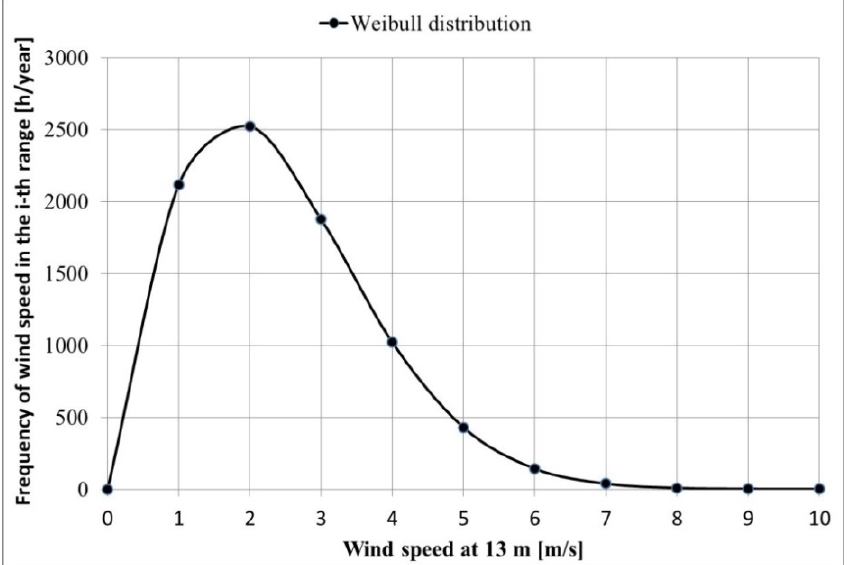
Figure 4. The Weibull distribution for the anemometer at 13 m above ground level for location I.